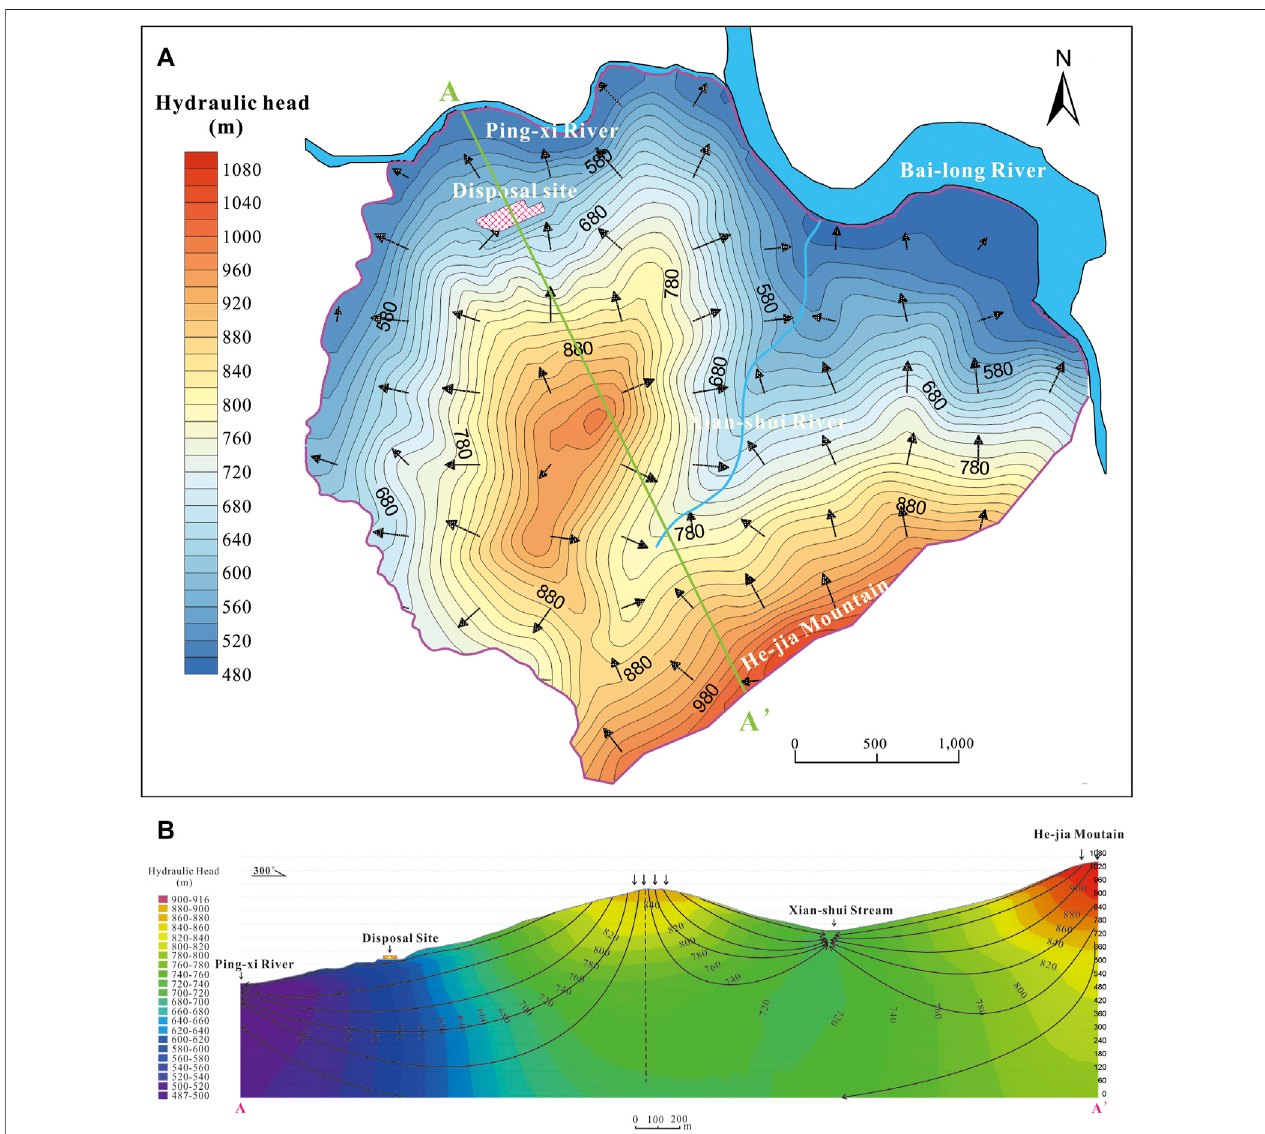
FIGURE 8 | (A) Flow fi eld diagram of the study area in 2,150. (B) Flow fi eld pro fi le in the northwest direction in